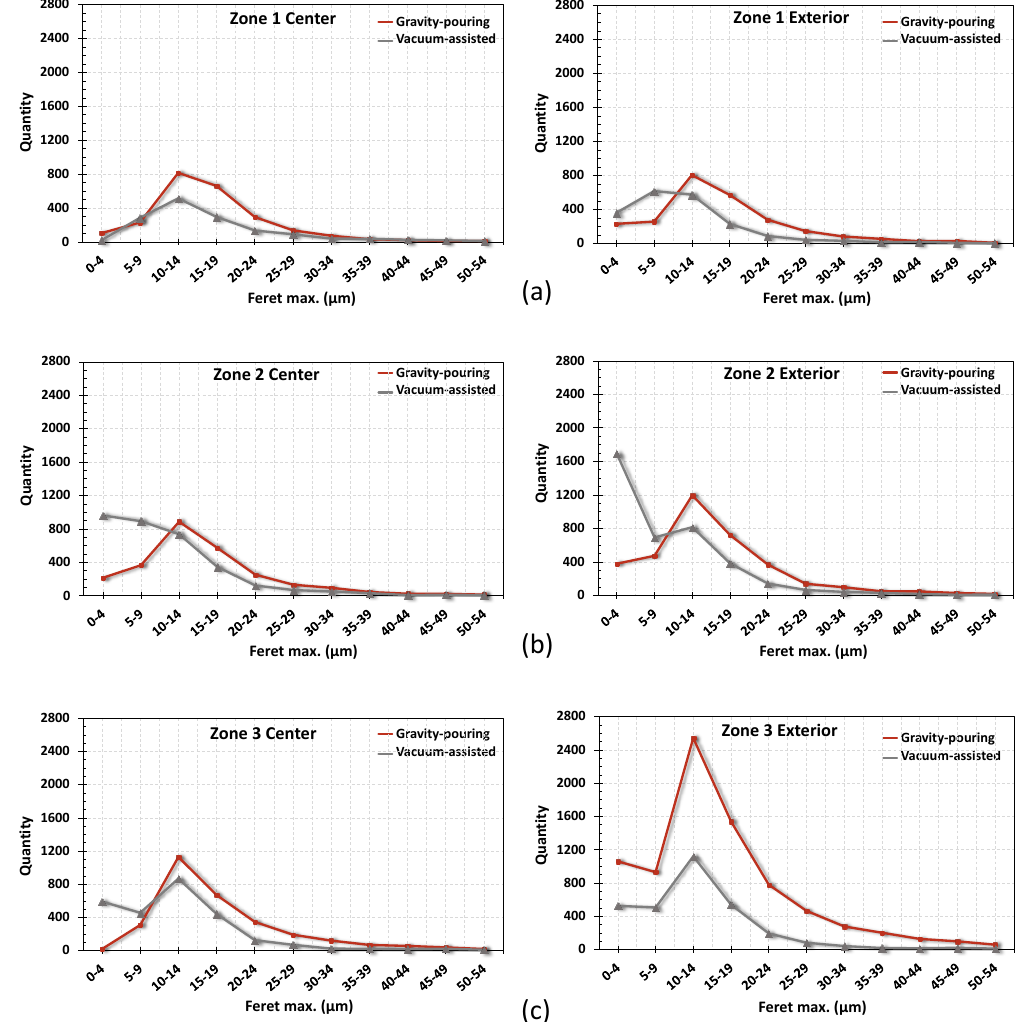
Figure 12. Statistical analysis of pore size by area and location. ( a ) Zone I, ( b ) zone II and ( c ) zone III.